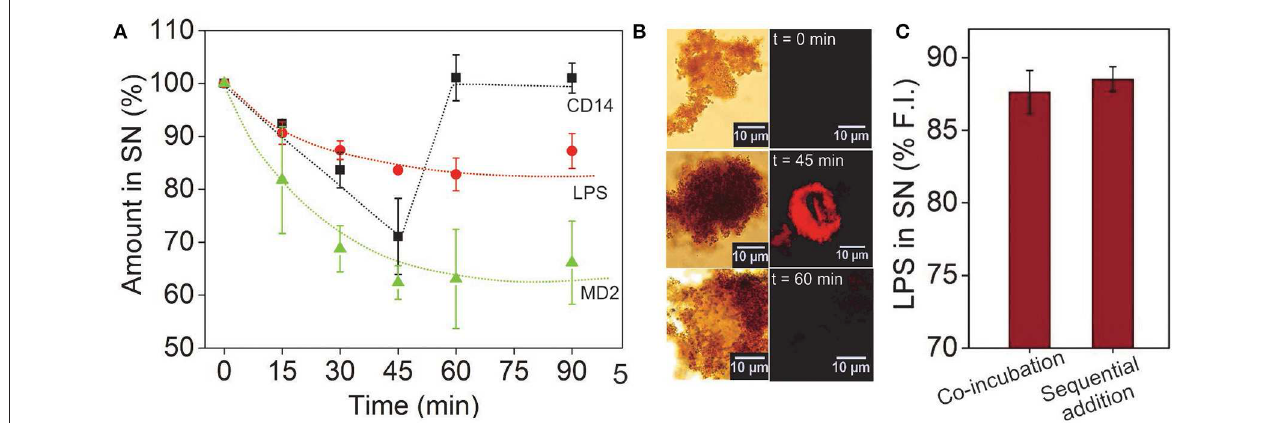
FIGURE 4 | (A) Time-lapsed measurements of LPS, MD2, and CD14 concentrations showing molecular binding kinetics and the role of CD14 as a catalyst. While the LPS and MD2 molecules were measured using their fluorescence intensity in the SN, CD14 was quantified via silver staining. (B) CD14 visualized after alexafluor tagging ( λ em = 647nm). The complementary brightfield and fluorescence optical images showed CD14 in the bound state only in the middle of the reaction cycle. (C) Varying the sequence of molecular addition had little impact on the extent of LPS capture. Here, sequential addition implies prior incubation of CD14 with LPS and MP-rTLR4 with MD2 followed by their rapid mixing as opposed to co-incubation of all the reagents from the beginning ( n = 3) (SN = supernatant). signals that played duel role in NF-kB activation and glycolysis.